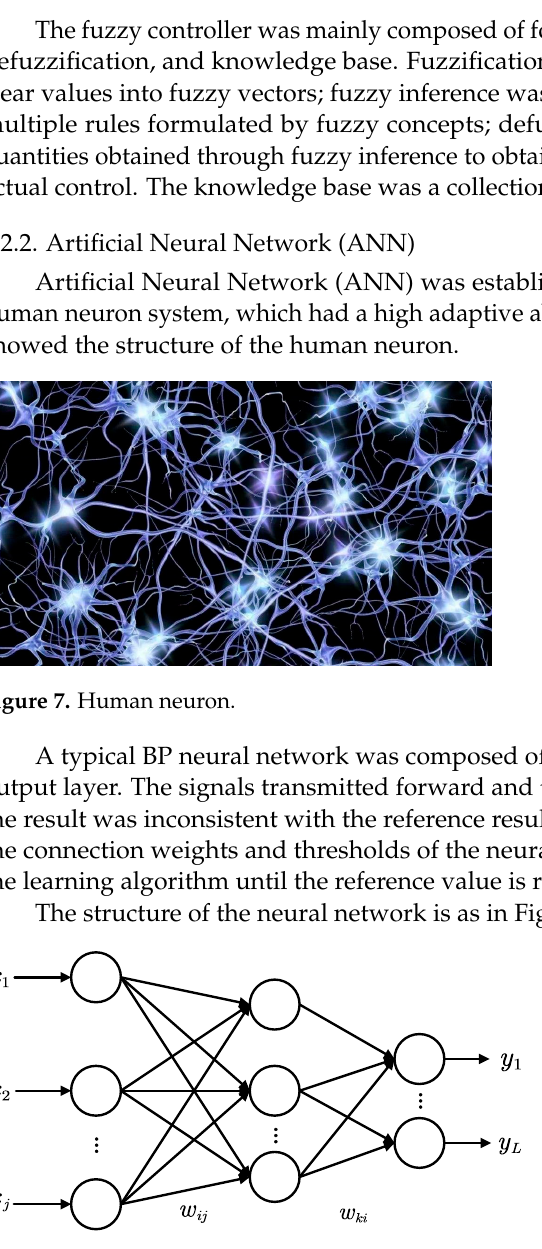
Figure 6. Fuzzy controller system structural.